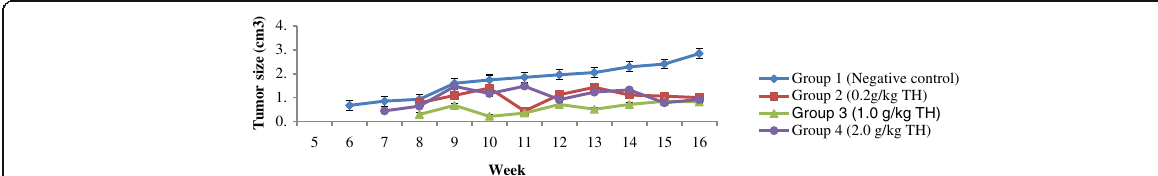
Fig. 1 Tumor size (cm 3 ) progression measured against time taken (in weeks) after MNU induction. Data are expressed as median interquartile range (IqR). Kruskal-Wallis test: values are not statistically significant in all weeks of experimental period, p > 0.05. Legends: TH = Tualang honey, MNU = 1-methyl-1-nitrosourea Negative control = group that received tumor induction but no honey treatment